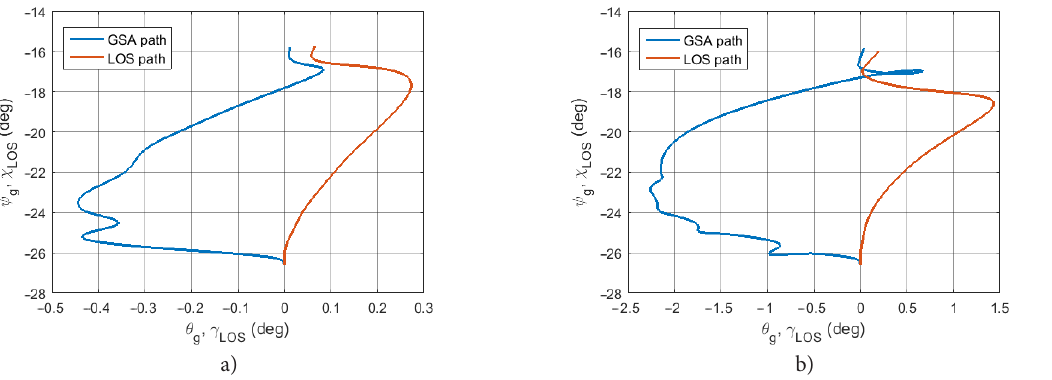
Figure 8. Actual and desired gyroscope system trajectories, for: a) LQR, b) PD